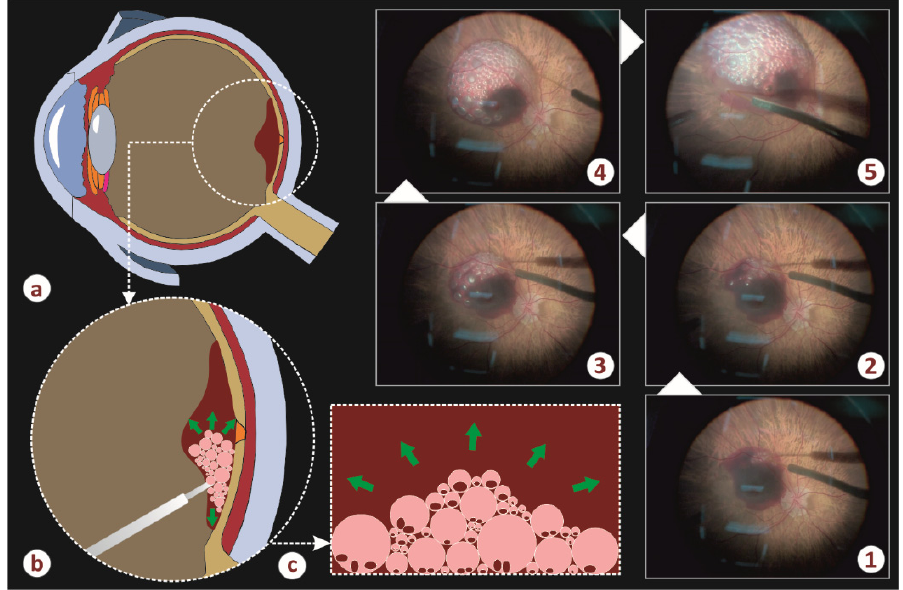
Figure 2. The key steps of the procedure followed. The graphics ( a – c ) illustrate a schematic representation of the procedure, while photos 1 to 5 depict the course of the procedure during the surgery, on the phase where air micro-bubbles are injected subretinally.